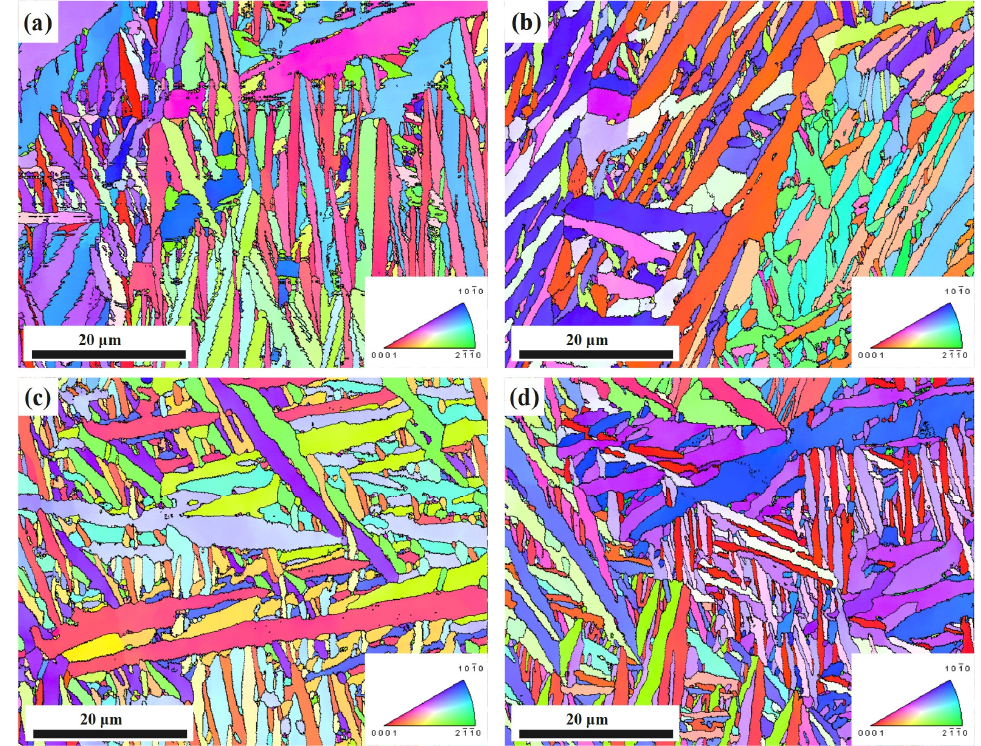
Figure 8. The IPF maps before and after stress relief treatments: ( a ) #0 (untreated); ( b ) #5 (TVSR: 380 ◦ C, 400 MPa); ( c ) #1 (VSR: 400 MPa); ( d ) #2 (TSR: 580 ◦ C). Figure 9 shows the EBSD analysis results of the grain sizes of specimens #0 (un- treated), #1 (VSR: 400 MPa), #2 (TSR-580 °C) and #5 (TVSR-380 °C–400 MPa). The equiva- lent grain diameters of all samples are mostly less than 10 µm, and the maximum differ- ence between the average grain area of each sample is only 0.85. µm2, but the length of α platelets is mostly in the range of 10~20 µm. Therefore, the width of α platelets hardly changed after stress relief treatments.